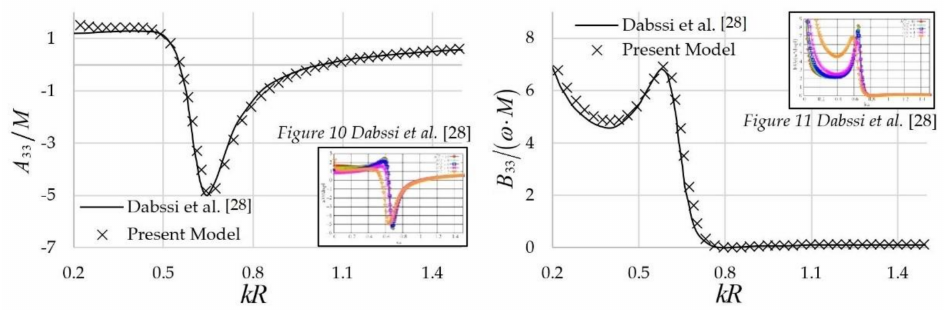
Figure 4. Added mass and damping coefficient of heave, for a twin-hull floating structure of semicircle hull cross sections ( 2 P / R = 3, h / R = 2 )